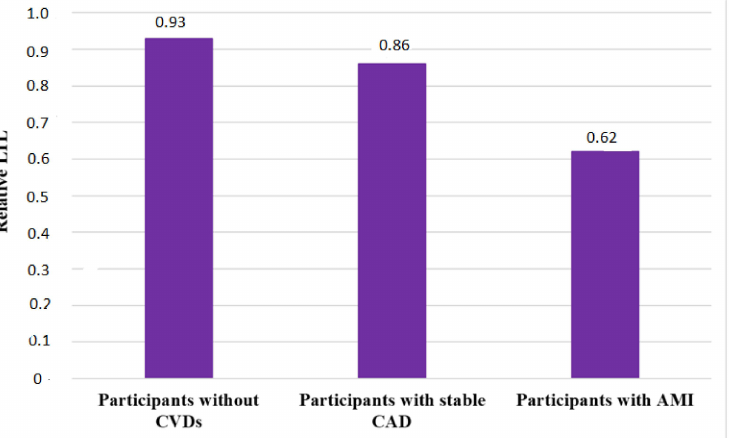
Figure 3. Median Relative Leukocyte Telomere Length in Patients with Coronary Heart Disease and Acute Myocardial Infarction Compared to Healthy Controls: AMI—acute myocardial infarction; CVDs—cardiovascular disease; CAD—coronary artery disease; LTL—leukocyte telomere length (CU—conventional